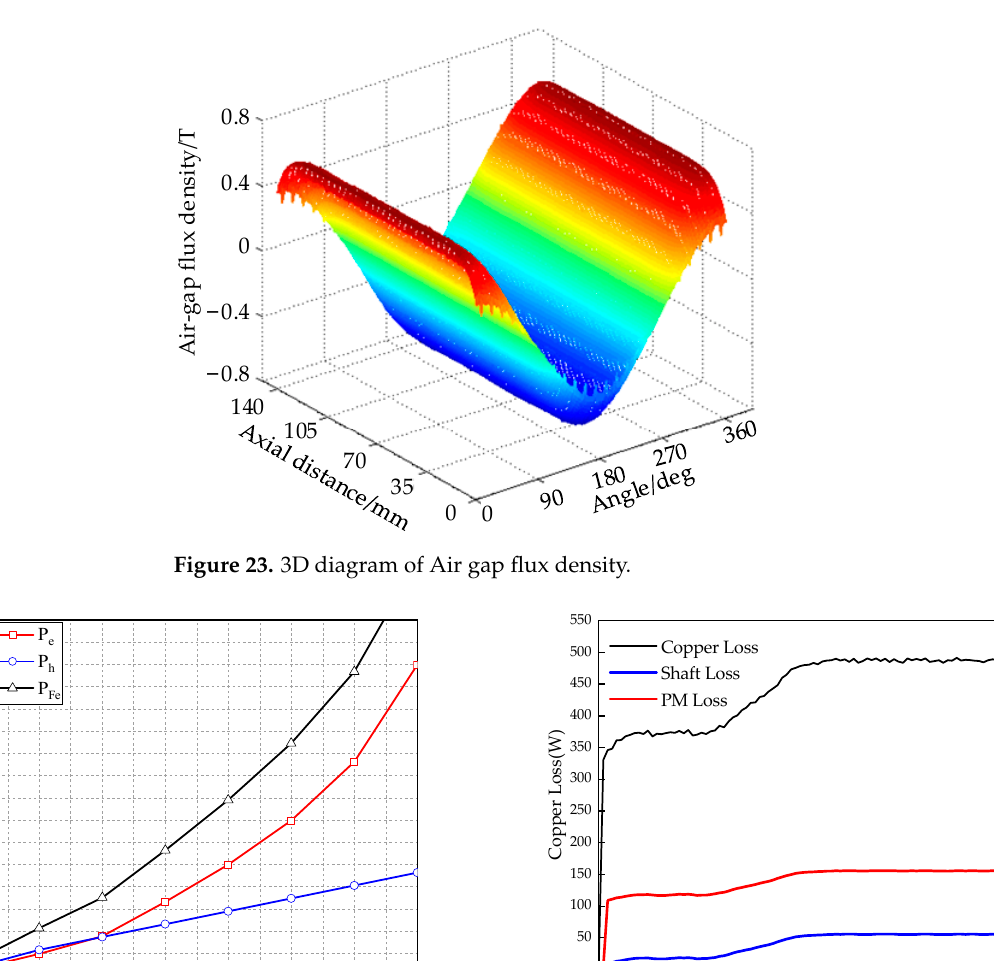
Figure 22. Flux line and flux density of High ‐ speed PM motor: ( a ) Cloud diagram of flux line of high ‐ speed motor; ( b ) Cloud diagram of flux density of high ‐ speed motor.